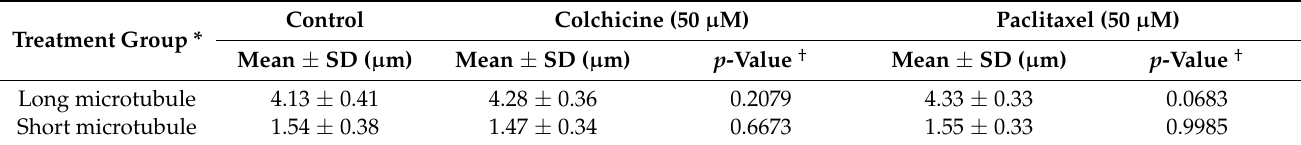
Table 1. Length of the two microtubules in sporozoites treated with colchicine or paclitaxel during the excystation process. Treatment Group * Long microtubule Short